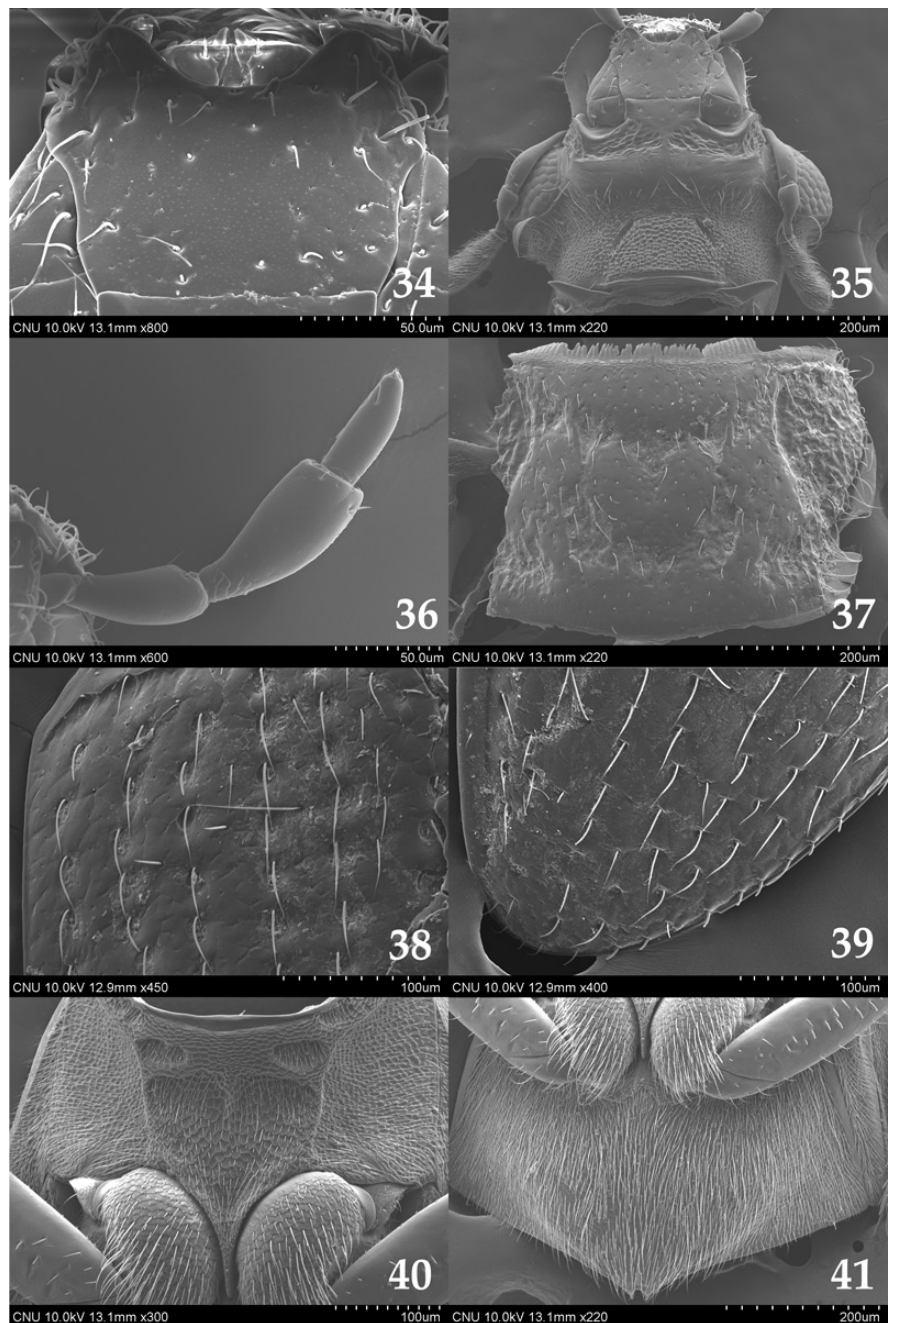
Figures 34–41. Ochthebius marinus . 34 mentum (ventral aspect) 35 head (ventral aspect) 36 maxillary palpus (ventral aspect) 37 pronotum (dorsal aspect) 38 anterior part of elytron (dorsal aspect) 39 pos- terior part of elytron (dorsal aspect) 40 mesoventrite (ventral aspect) 41 metaventrite (ventral